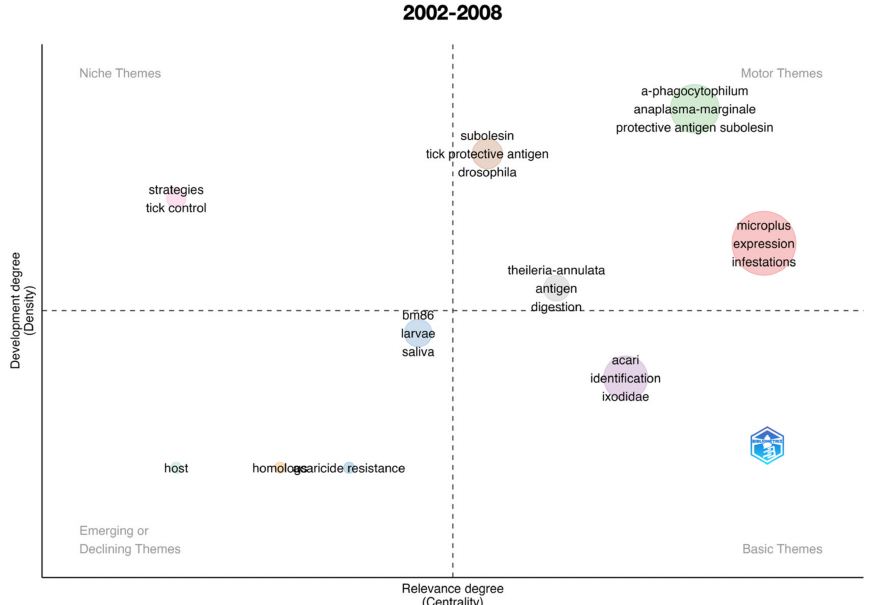
Figure 3. Thematic roles of the documents published on the topic “anti–tick vaccination” in the period 1996–2002.